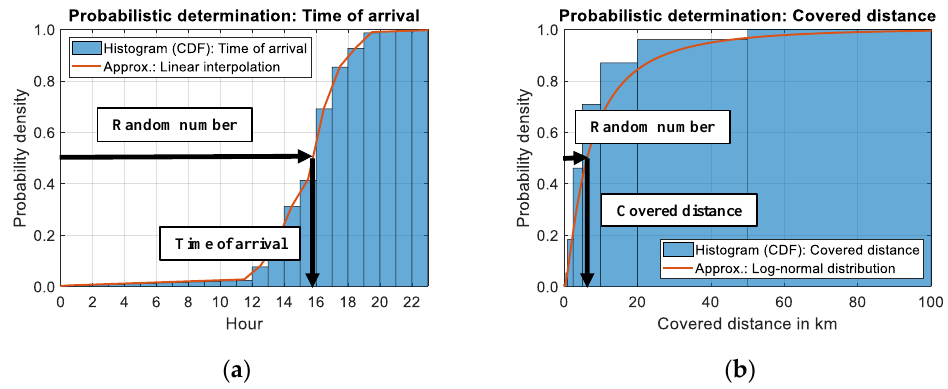
Figure A4. Probabilistic determination of time of arrival ( a ) and covered distance ( b ) based on real mobility data.